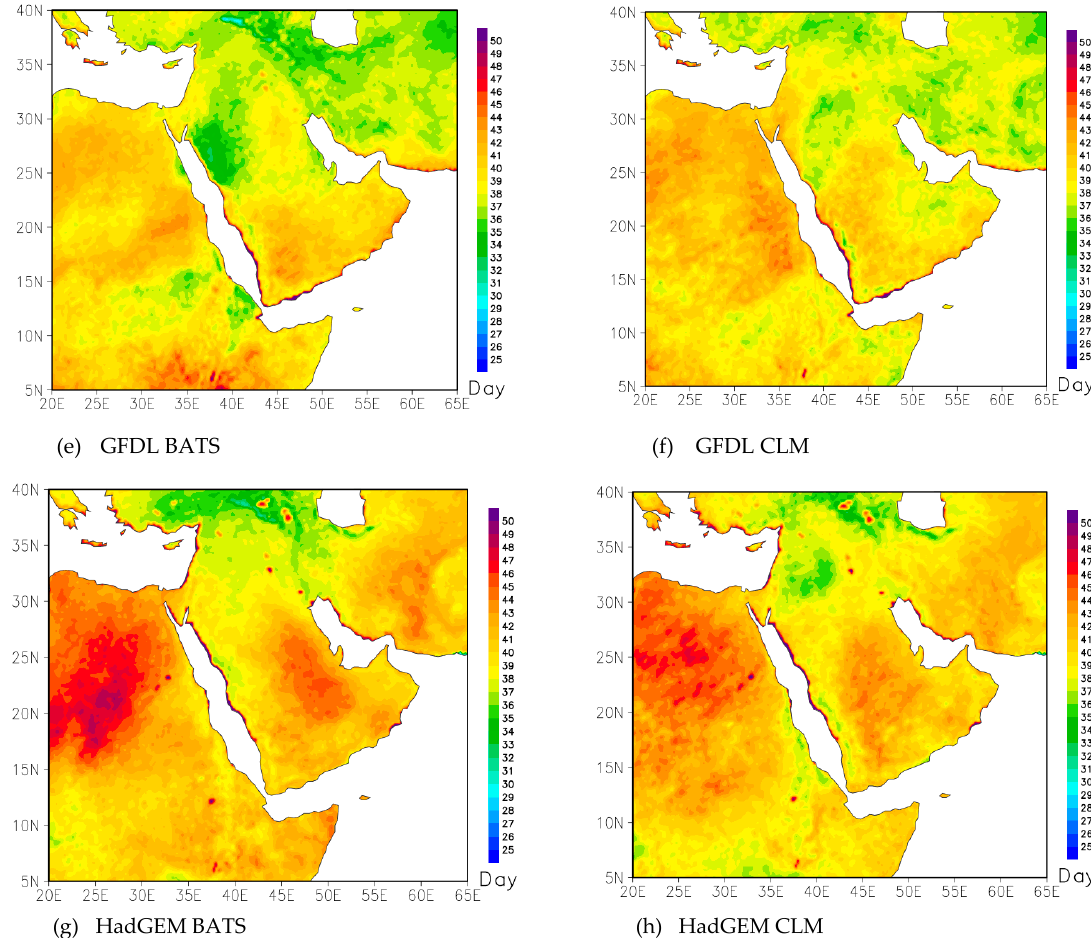
Figure 4. Spatial distribution of annual warm days (TX90p) for ( a ) ERA–Int BATS, ( b ) ERA–Int CLM, ( c ) ECHAM6 BATS, ( d ) ECHAM6 CLM, ( e ) GFDL BATS, ( f ) GFDL CLM, ( g ) HadGEM BATS, and (h)